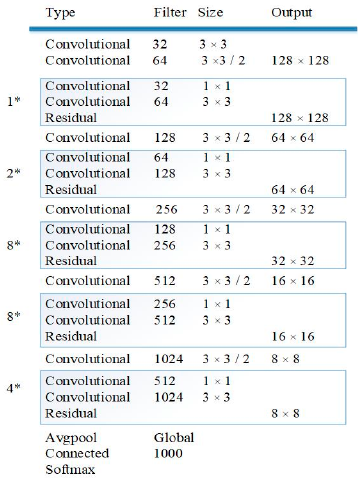
Figure 3. The architecture of the convolutional neural network.